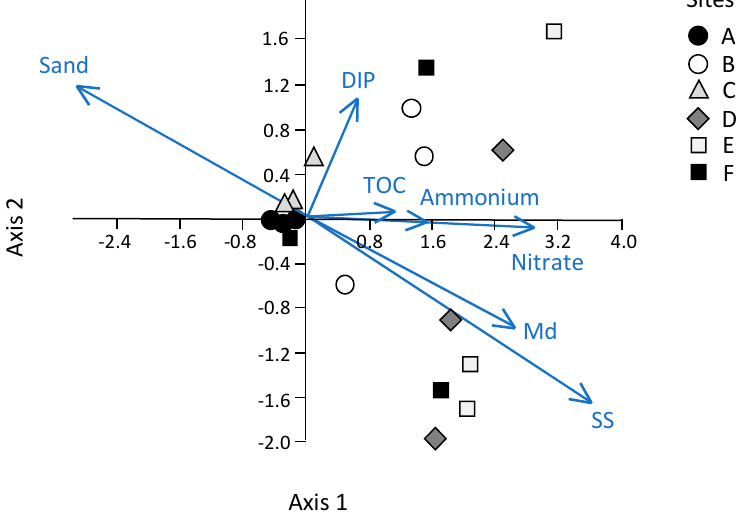
Figure 9. Plot of Canonical correspondence analysis (CCA) performed on species abundance and environmental variables most correlated with two axes and indicative of trophic (i.e., ammonia, nitrate, reactive phosphorus, and TOC) and hydrodynamic (i.e., suspended solids, sand, and size- particle) conditions.